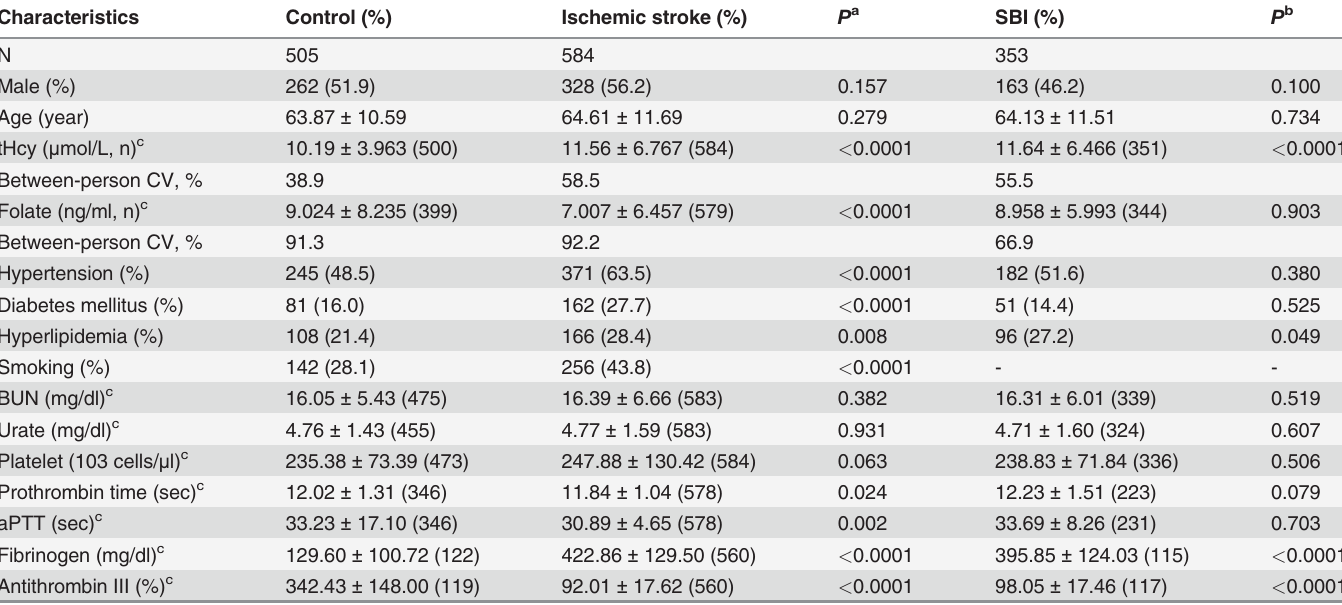
Table 1. Baseline characteristics of ischemic stroke patients, silent brain infarction (SBI) patients, and control subjects.